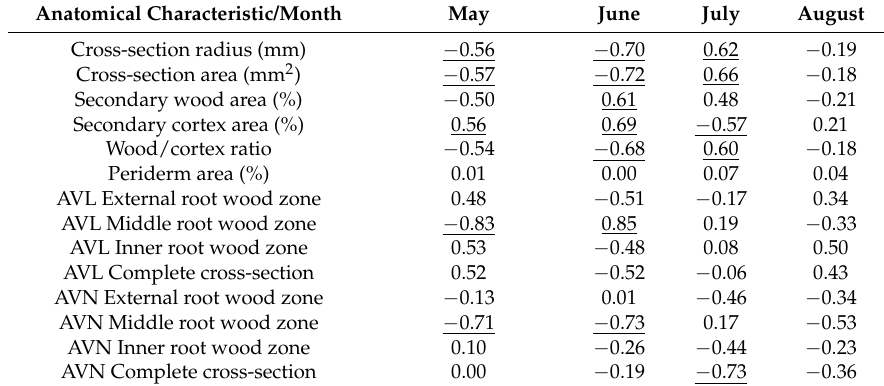
Table 6. Correlation coefficients of the investigated anatomical characteristics and a number of very hot days (T max > 30 ◦